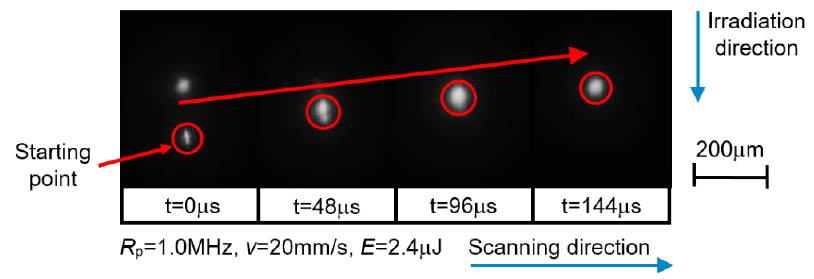
Figure 10. Observation of absorption point movement.